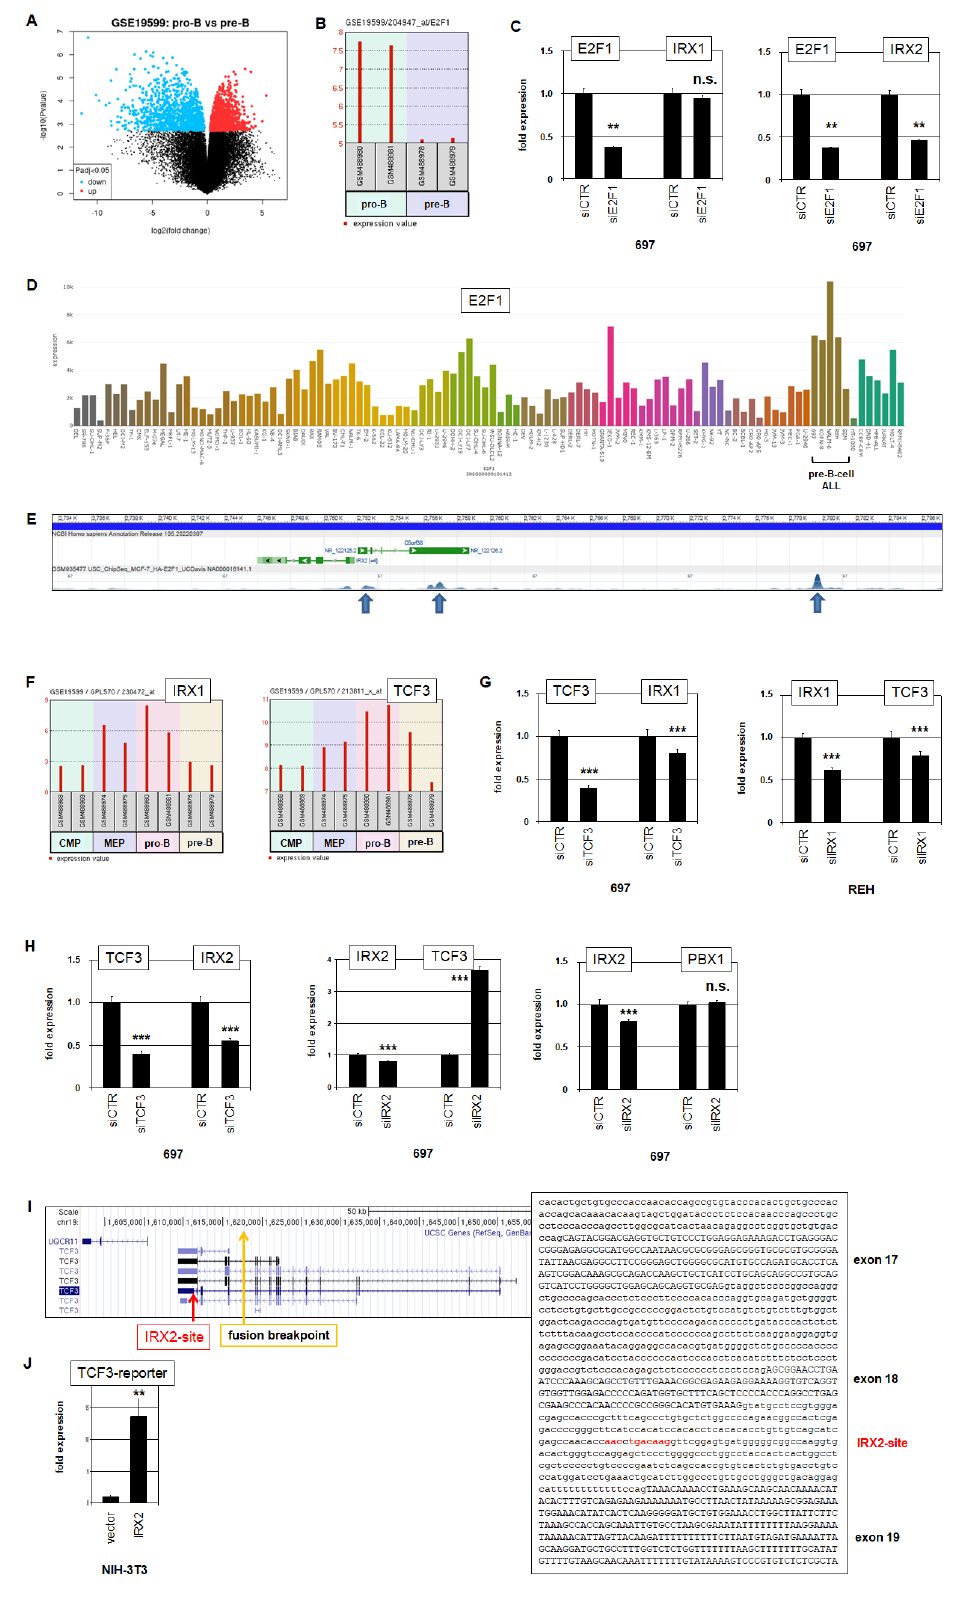
Figure 4. E2F1, TCF3, IRX1 and IRX2. ( A ) GEO2R analysis of expression profiling data from pro-B-cells and pre-B-cells (dataset GSE19599) was visualized as a volcano plot, showing